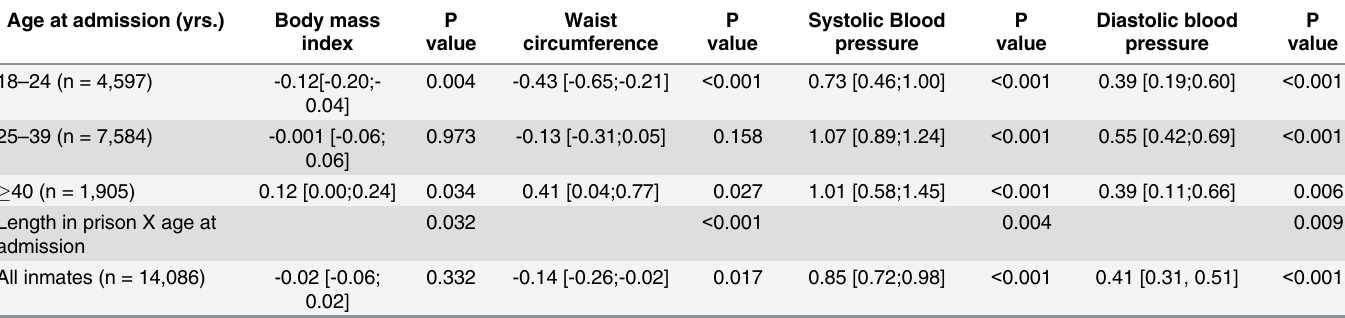
Table 3. Median change per year of incarceration for the main outcomes; stratified by age at admission to the prison. (Quantile regression model estimates). Age at admission